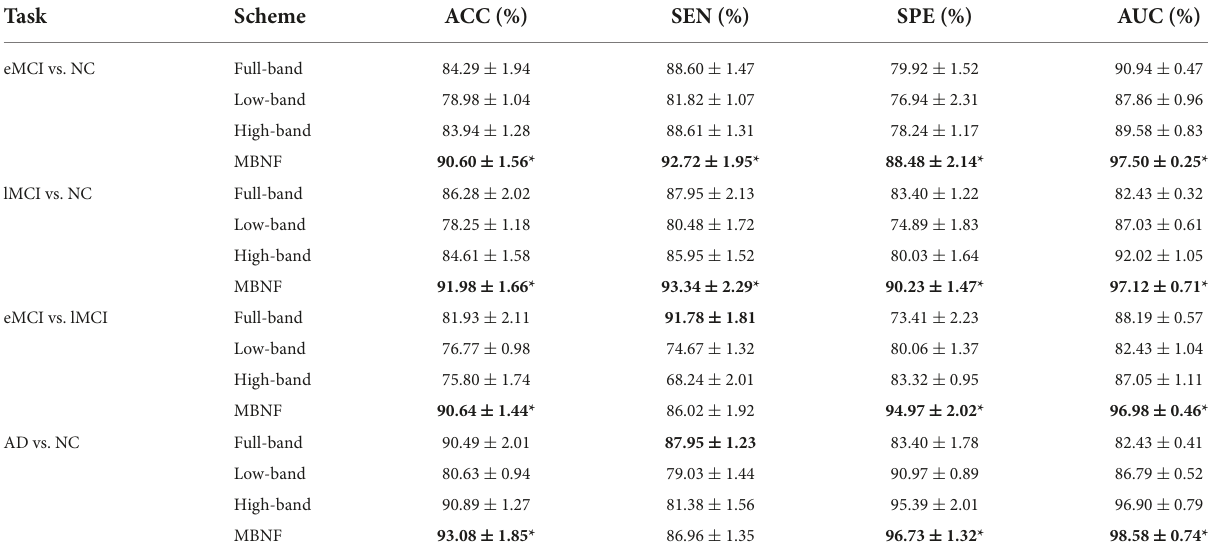
TABLE 2 Classification performance of four schemes in four classification tasks based on Pearson’s correlation (PC) construction method (mean ± standard deviation).